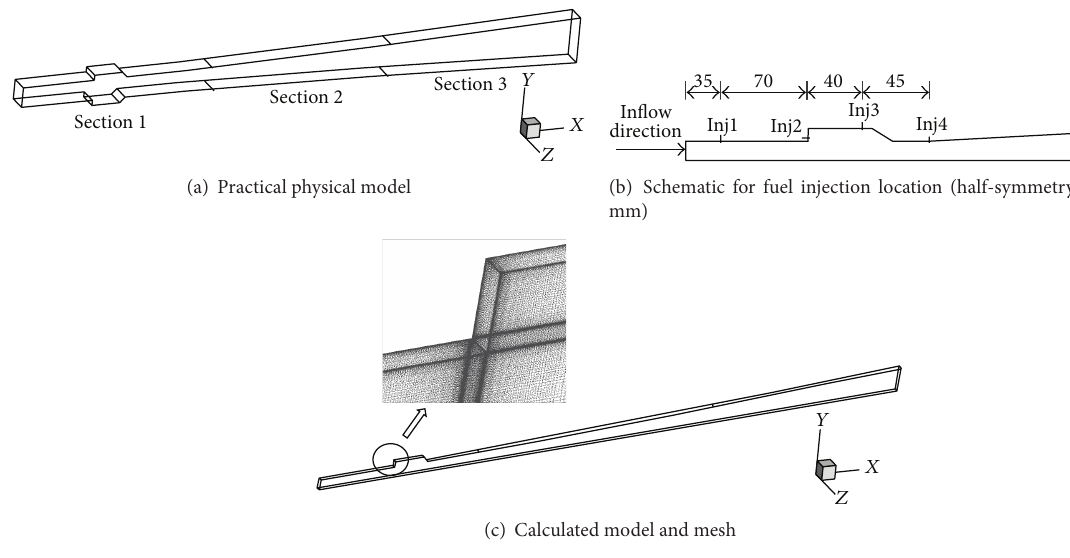
Figure 2: Physical model and mesh.